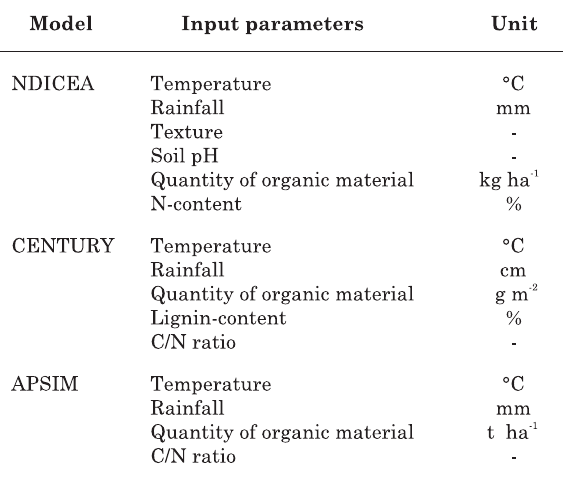
Table 3. Main input variables used in simulation models for tropical